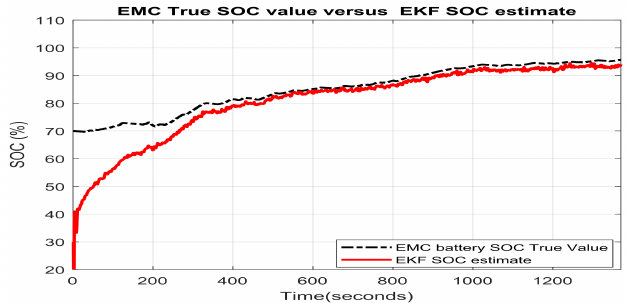
Figure 20. The robustness of EKF estimator to simultaneous changes in SOC initial value and in measurements current sensor noise level.